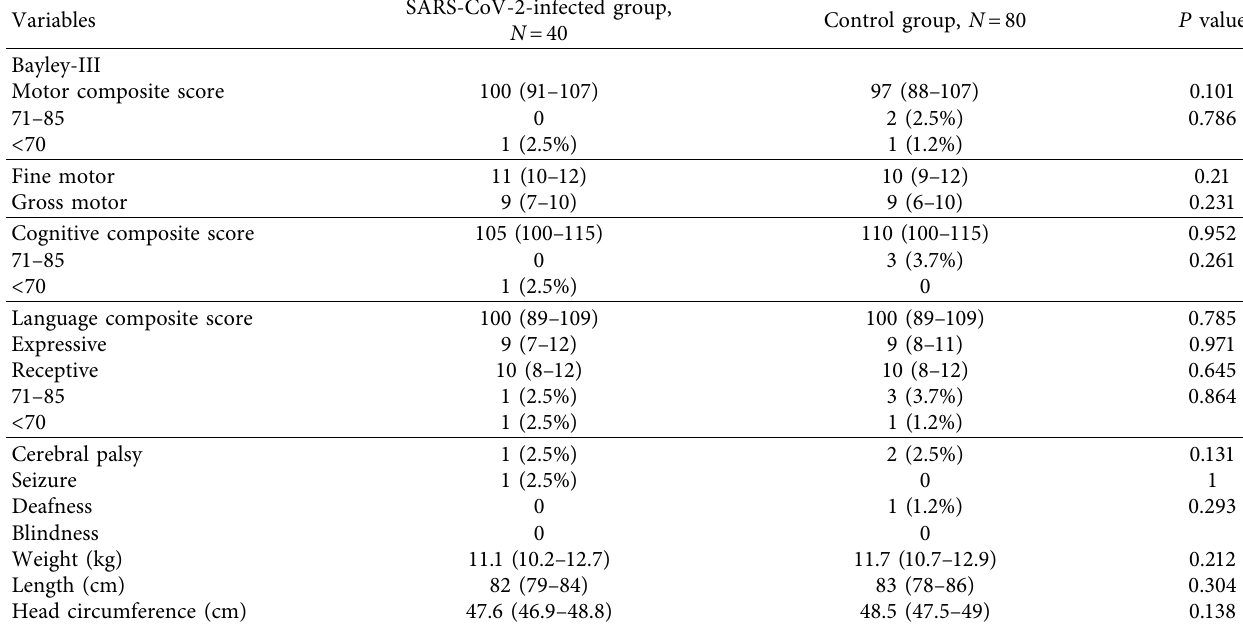
Table 2: Follow-up outcomes at